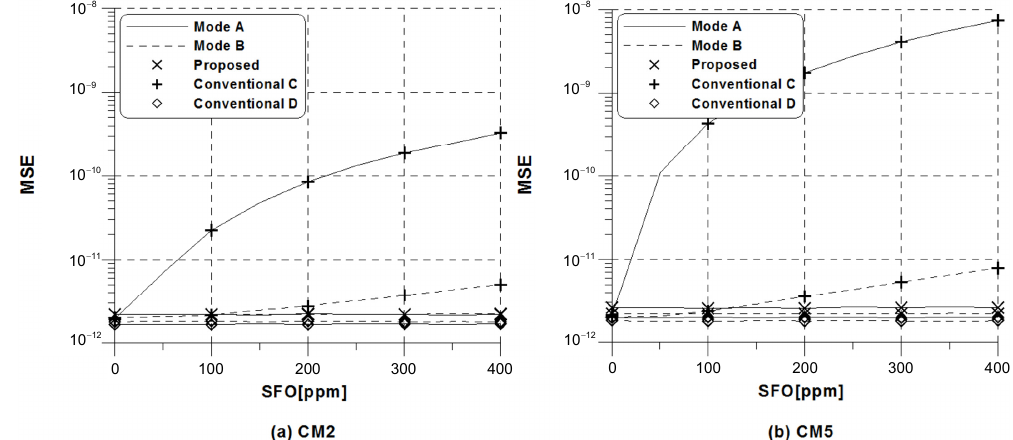
Figure 5. MSE of the conventional and proposed frequency estimators versus SFO for DRM modes A and B when SNR = 40